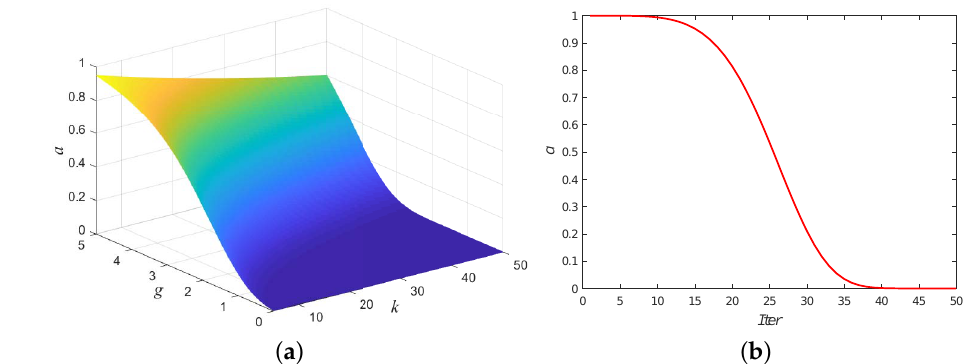
Figure 5. Selection of relevant parameters of the moving step in the DSFSOA(distributed hybrid fish swarm optimization algorithm) algorithm. ( a ) the relationship between parameter k , g and a when Iter is 20 and IterNum is 50; ( b ) the relationship between a and Iter when k = 20 and g =